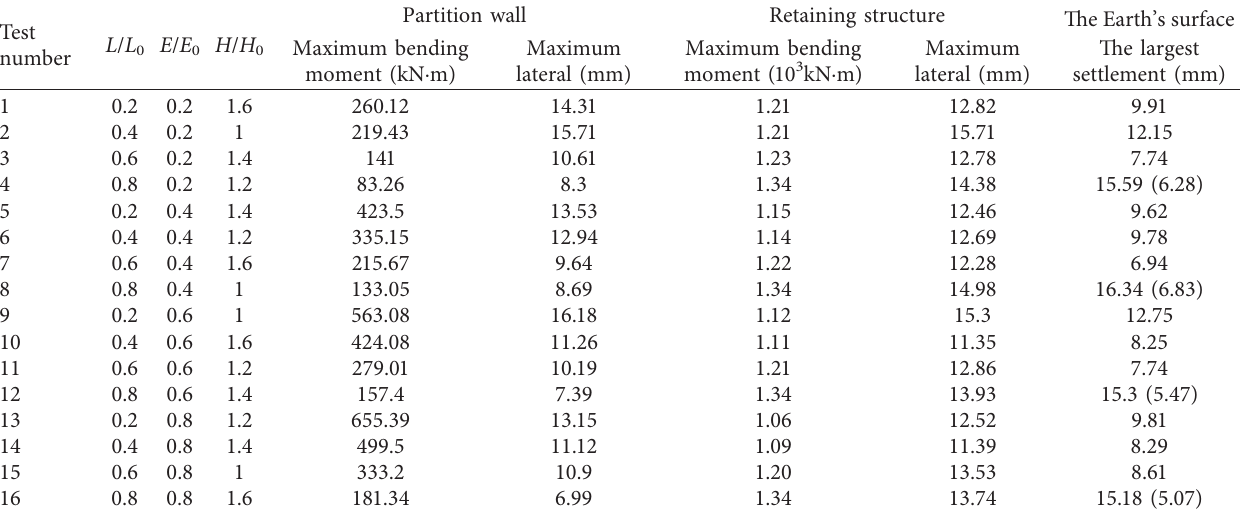
Table 7: Orthogonal test table.